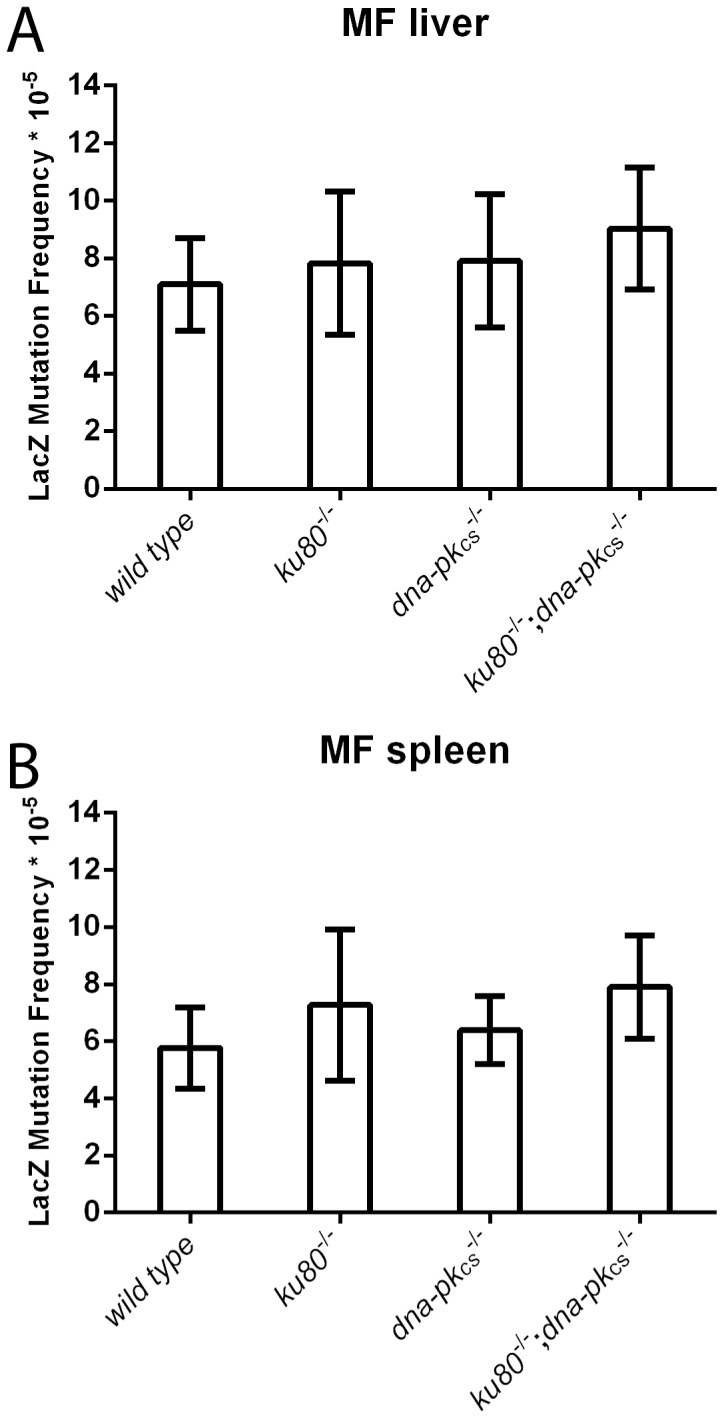
LacZ mutant frequency.Error bars represent standard deviation. (A) Mutant frequency in liver. (B) Mutant frequency in spleen.